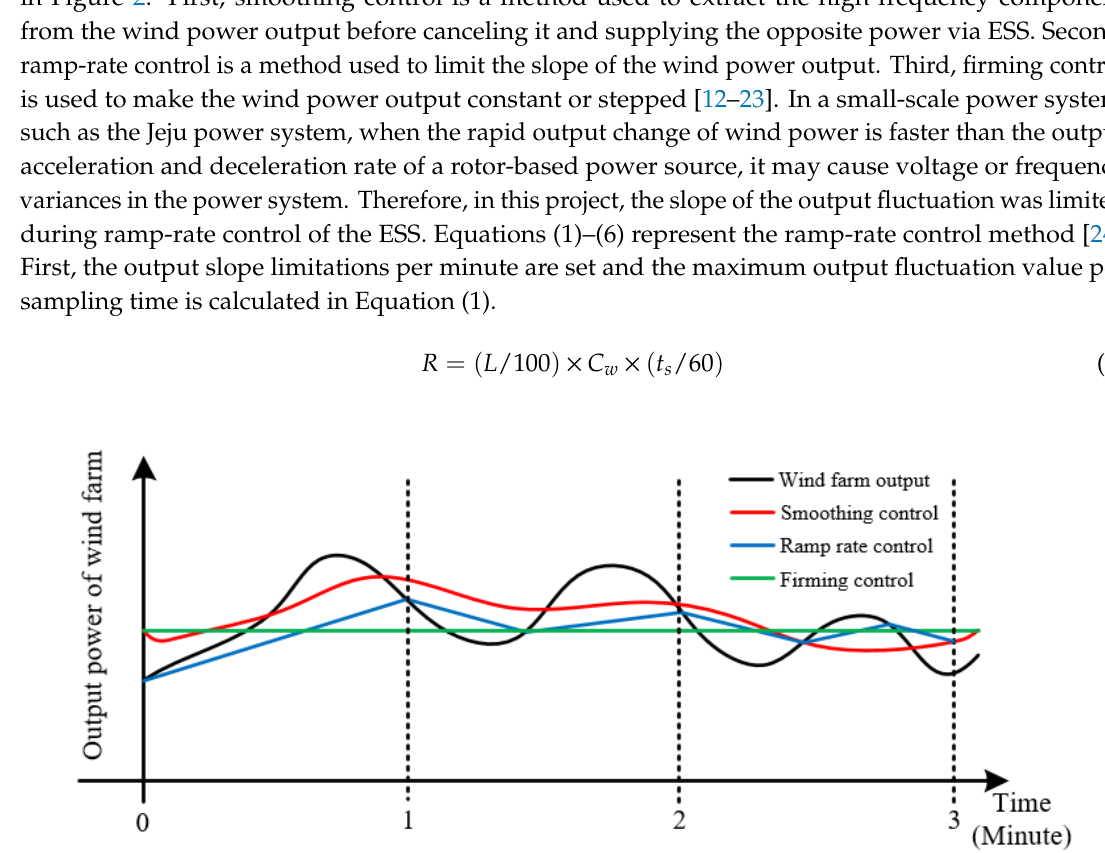
Figure 2. Examples of the wind power output control scheme using an energy storage system (ESS).